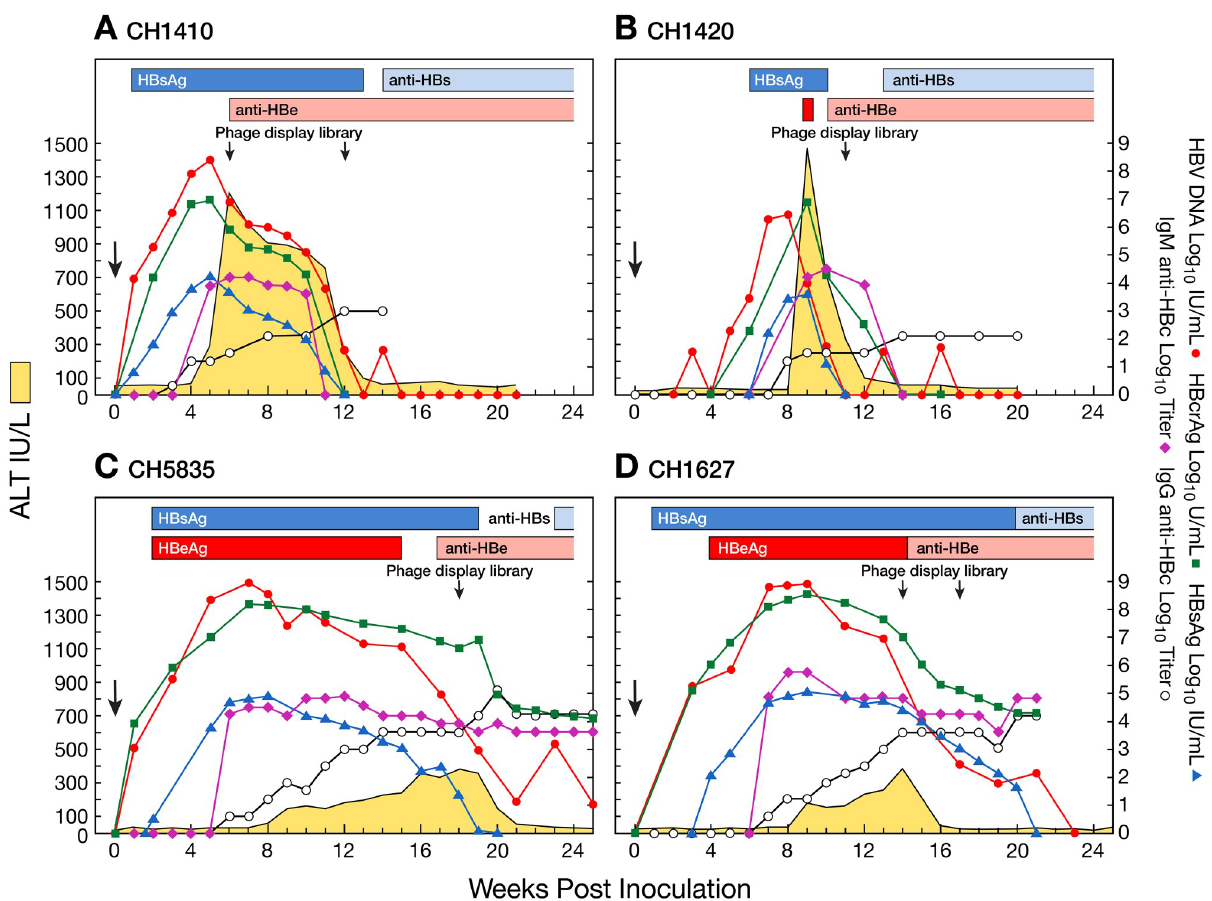
Fig 1. Biochemical, serologic, and virologic course of acute HBV infection in chimpanzees. (A and B) CH1410 and CH1420 were infected with a precore HBV mutant[15] and CH5835 and 1627 (C and D) with the wild-type HBV strain [11, 14]. Yellow areas indicate values for alanine aminotransferase. Each horizontal bar, which is identified by a different color, indicates the time at which serum HBsAg, HBeAg, anti-HBs and anti- HBe were positive. Each line, identified by a different color, indicates the serum titer of HBsAg, HBV DNA, HBcrAg, and IgG and IgM anti-HBcAg (logarithmic scale). The arrows indicate the time at which phage display libraries were performed in chimpanzees using liver specimens from different time points during the course of HBV infection.